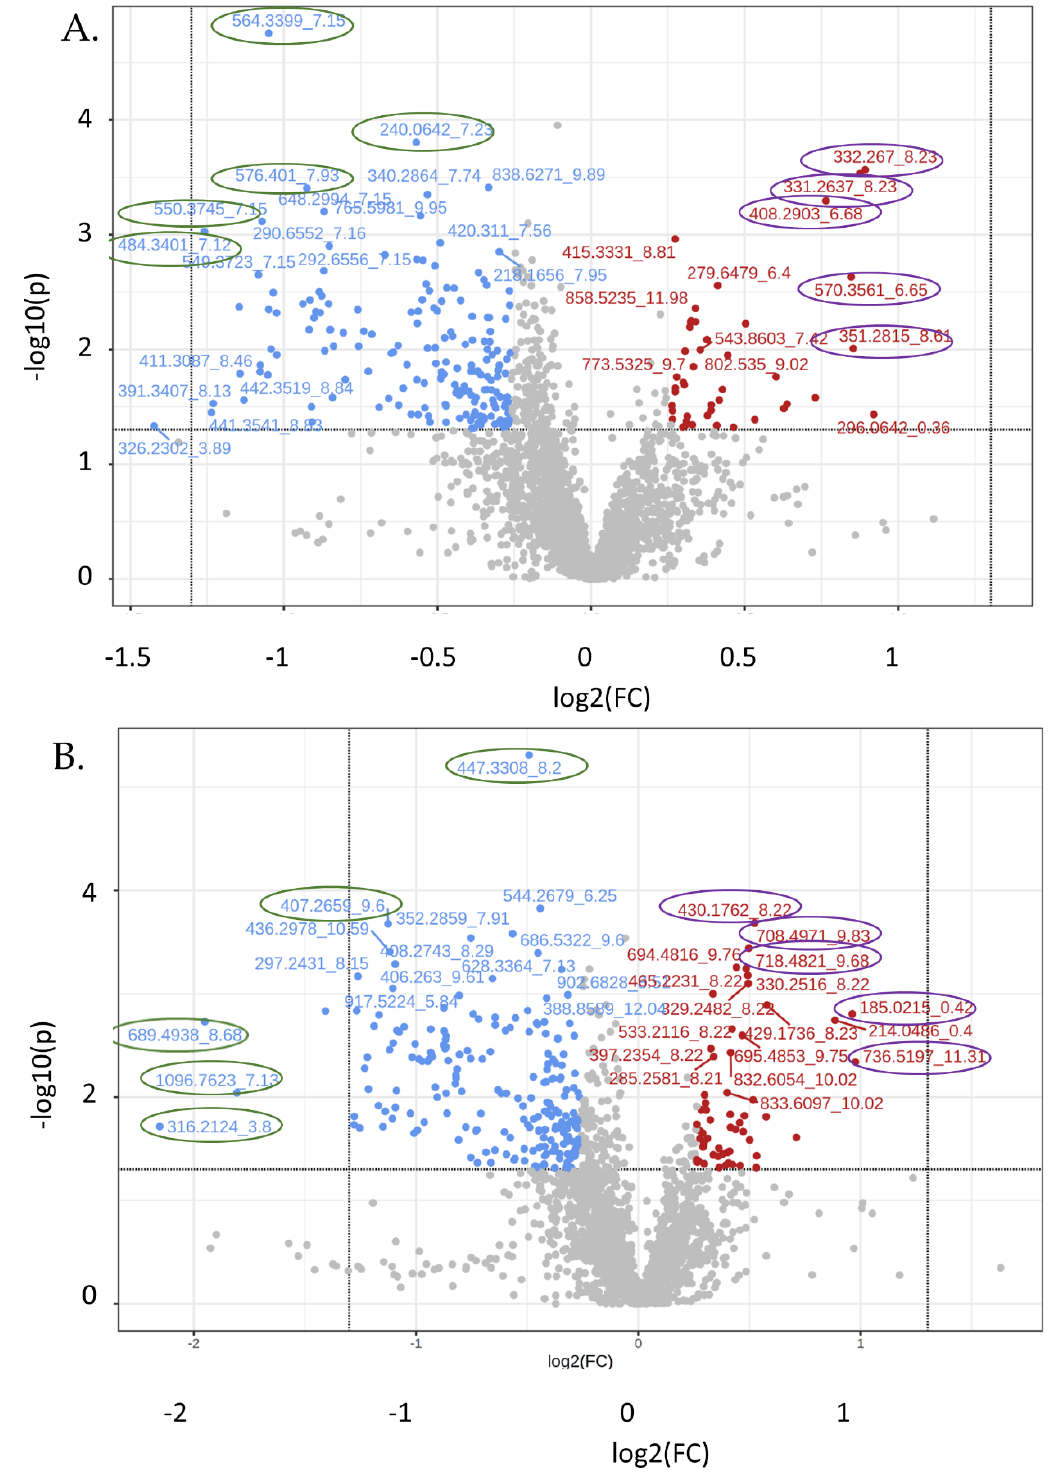
Figure 8. Volcano plot of untargeted features (mz_rt). ( A ) Positive; ( B ) negative modes. Blue and red dots indicate features changed (raw p -value < 0.05 and log2 FC > ±0.26). Encircled mz_rt were red dots indicate features changed (raw p -value < 0.05 and log2 FC > ± 0.26). Encircled mz_rt were entered into CEU-Mass Mediator for annotation query. entered into CEU-Mass Mediator for annotation